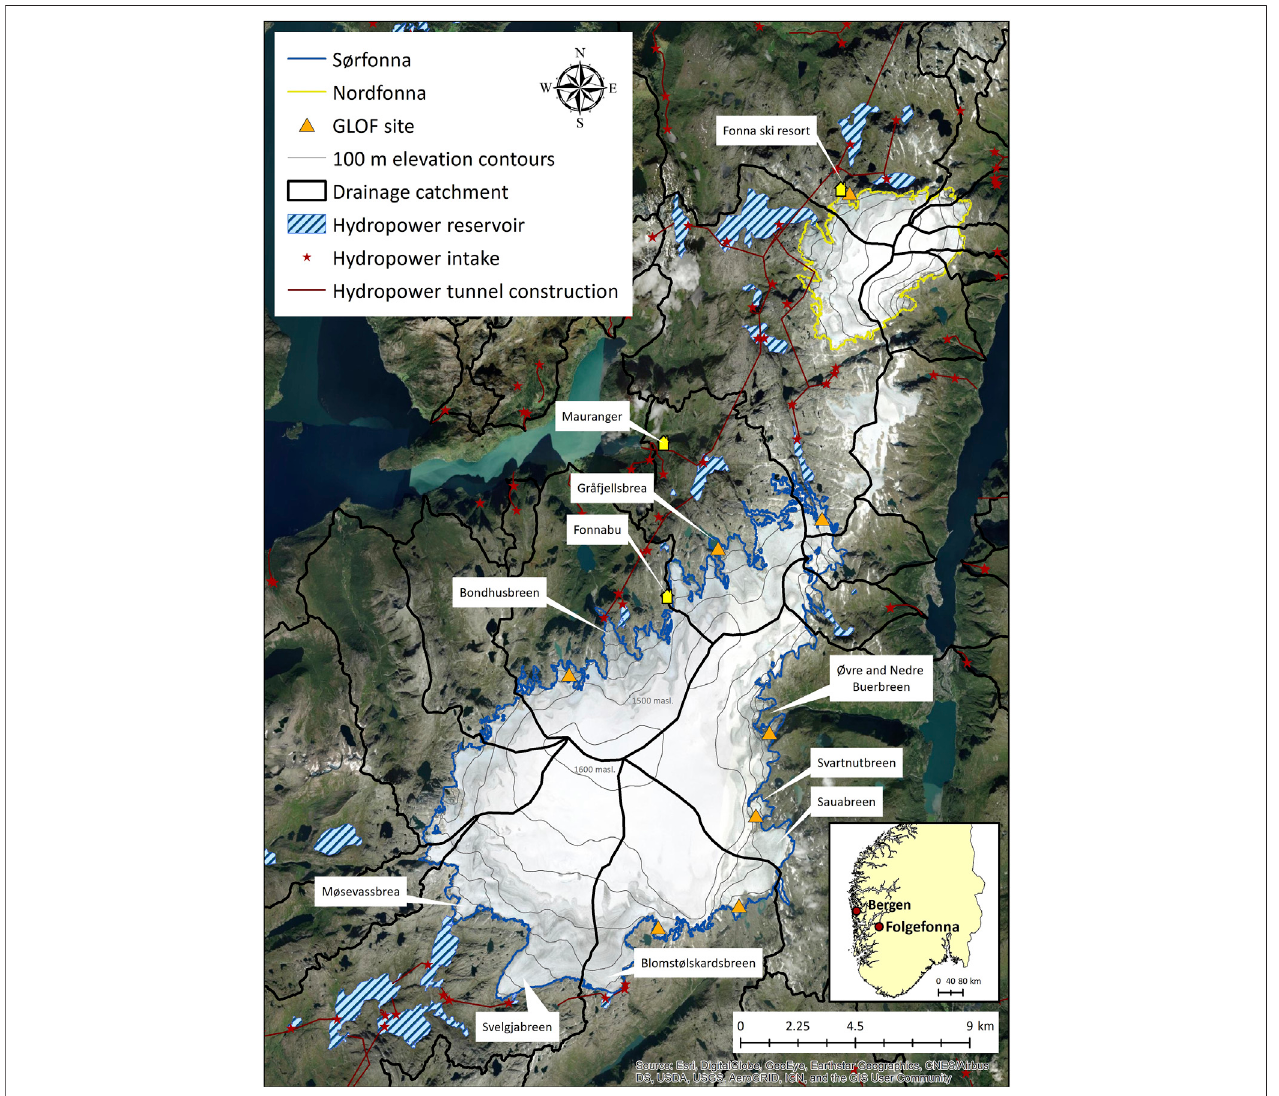
FIGURE 1 | Nordfonna (yellow boundary) and Sørfonna (blue boundary), with 100 m elevation contours (thin grey lines) in the centre. Sites with potential or historically observed glacial lake outburst fl oods (GLOFs) are marked with orange triangles (Jackson and Ragulina, 2014; Norwegian Water Resources and Energy Directorate, 2017). Hydropower constructions are marked with red stars and lines, reservoirs are marked with blue stripes, and drainage basins are marked with black lines. The outlet glaciers mentioned in the manuscript are marked by their names. The inset map (bottom right; ©EuroGeographics for the administrative boundaries) shows where in southwestern Norway Folgefonna (red dot) is